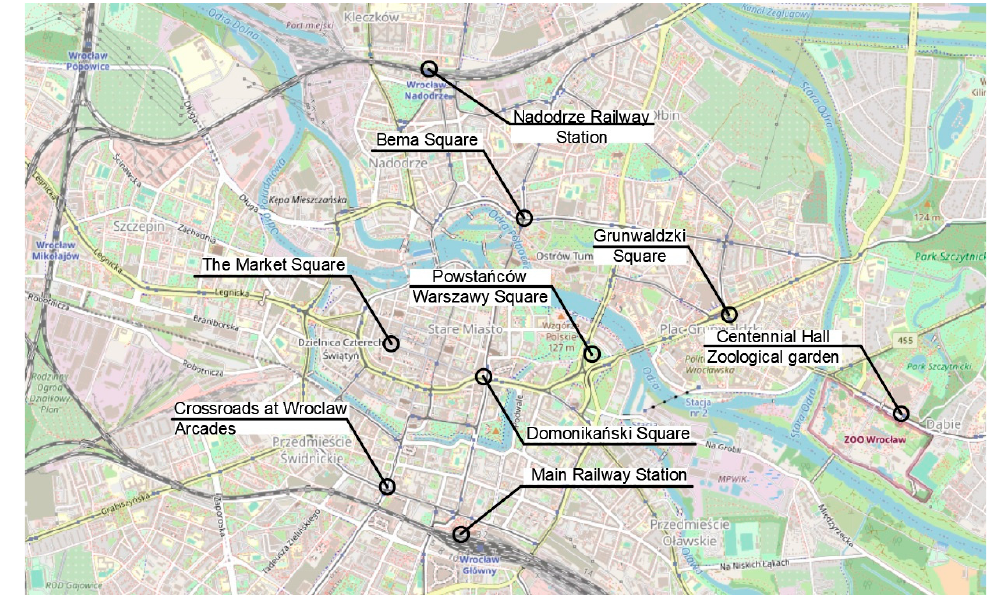
Figure 4. Traffic generators. (Background: openstreetmap.org).